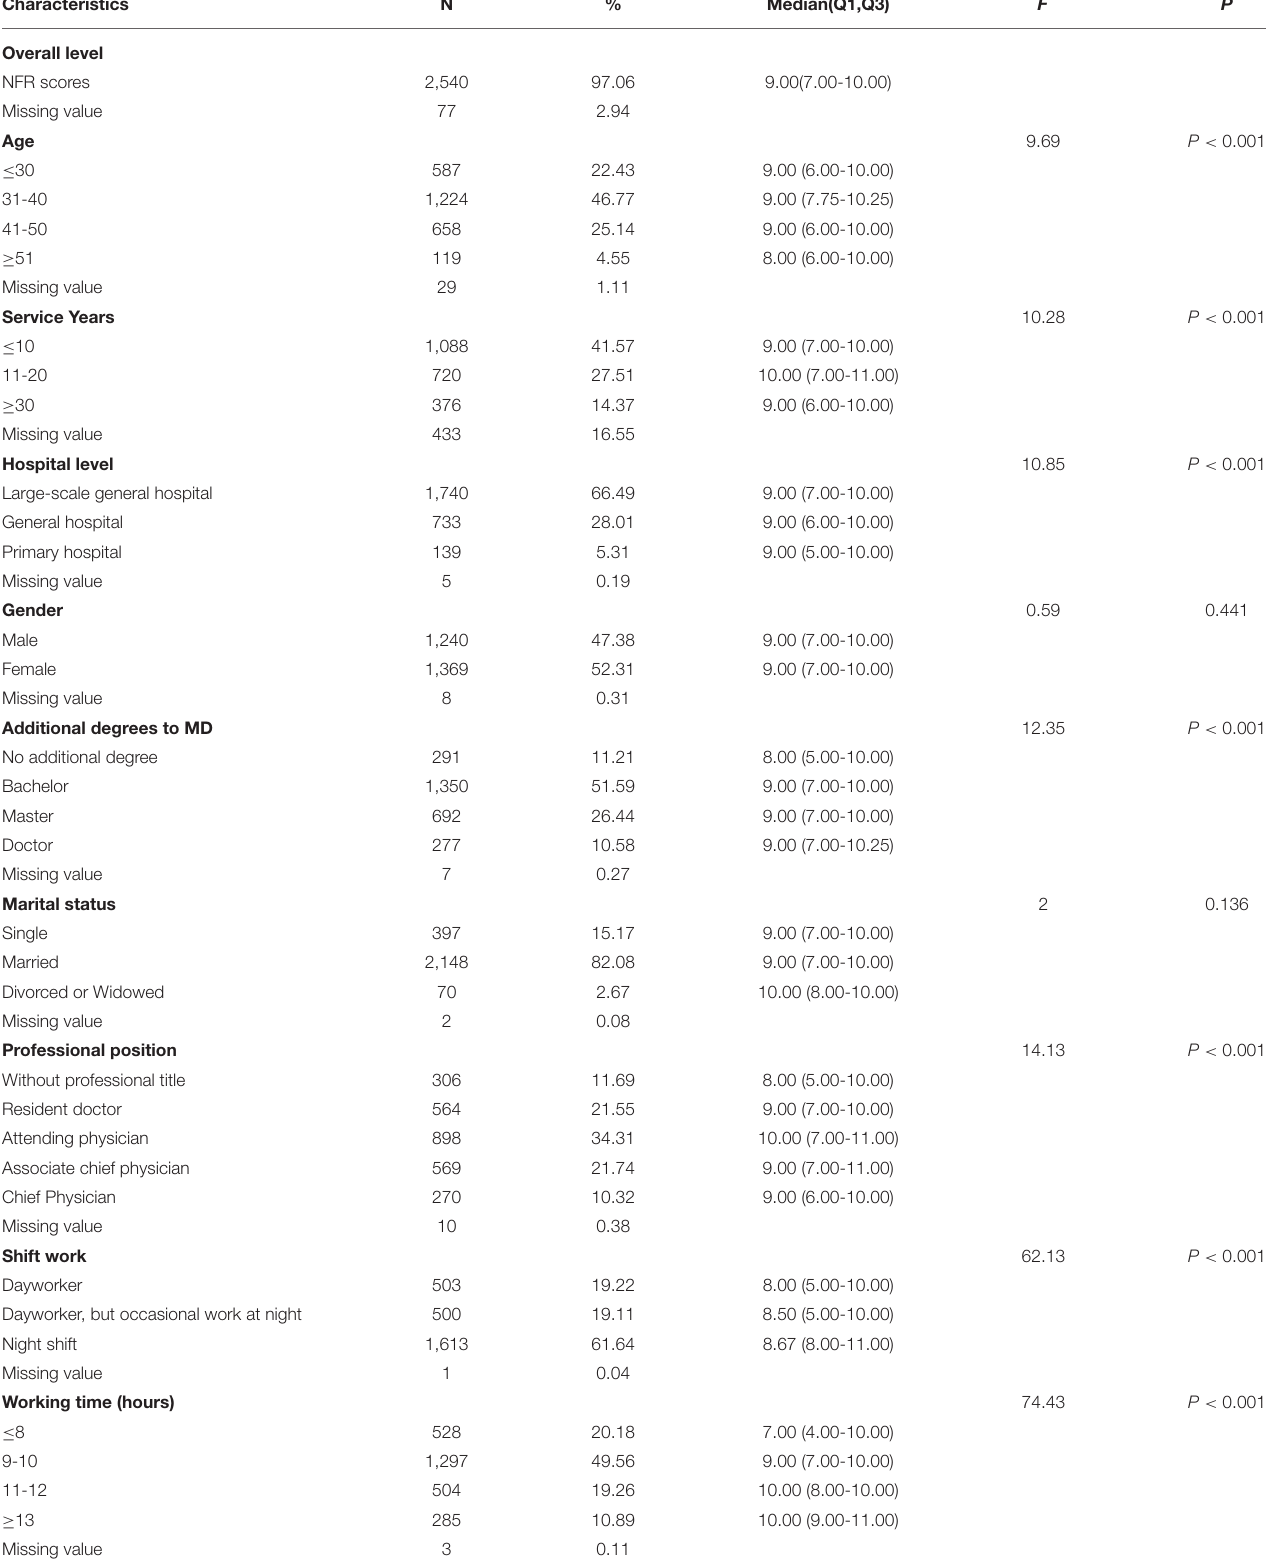
TABLE 1 | Characteristics of the respondents ( n = 2,617).